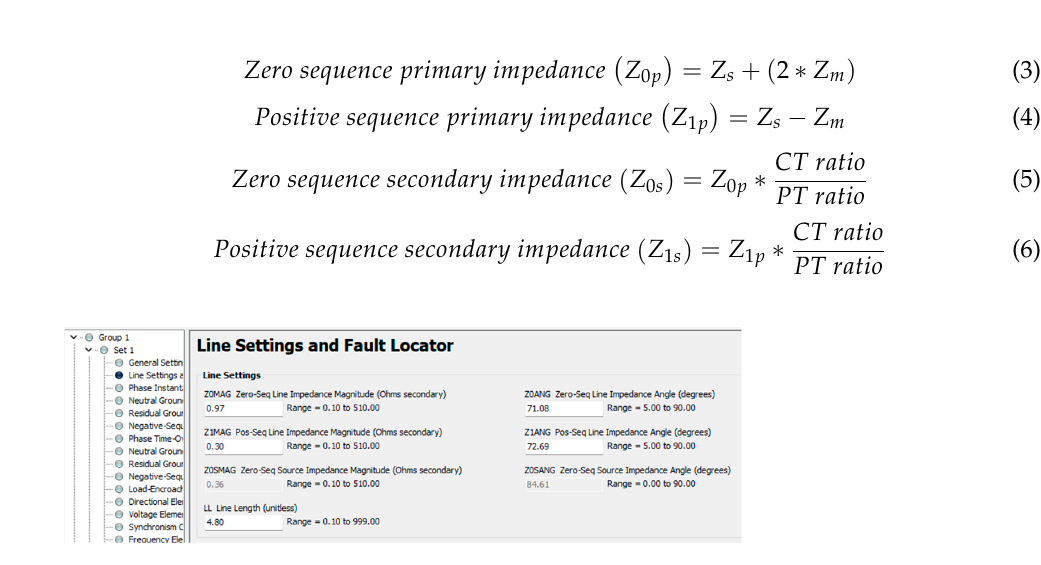
Figure 4. Entering parameters for ‘Line settings and Fault locator’ section.